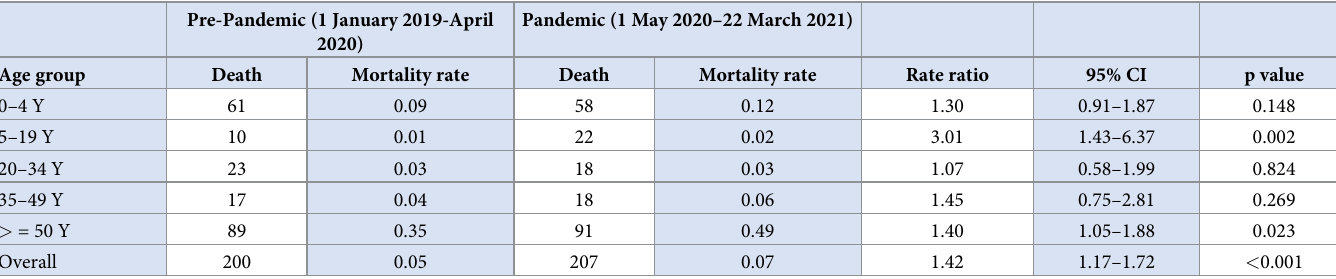
Table 3. Mortality rates by age group and period, Dagahaley refugee camp, Garisa County,